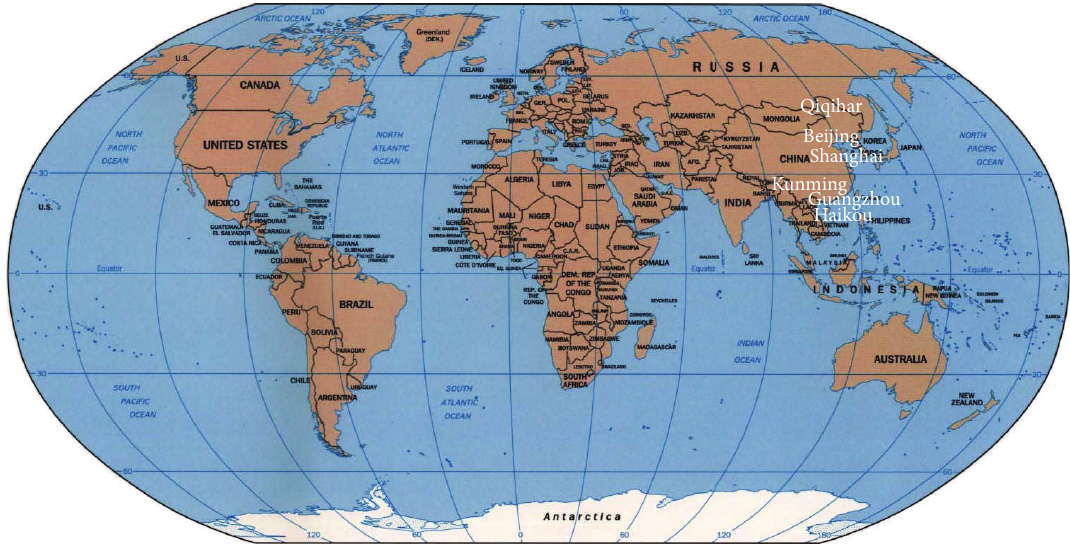
Figure 2: Location of six cities in China.